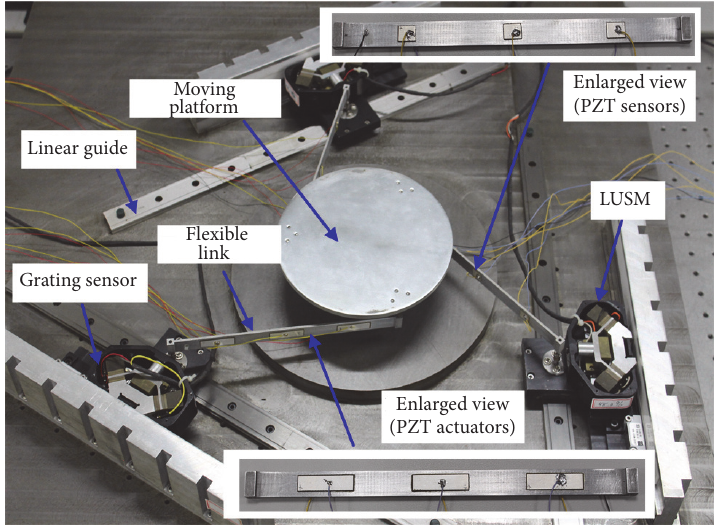
Figure 11: The layout of the PZT transducers and the setup of the